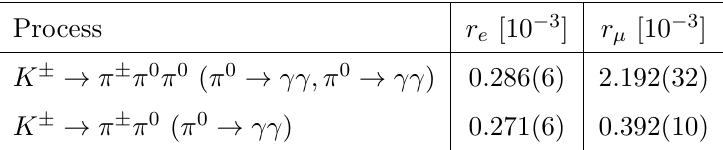
Table 2 . Background processes and background to signal ratios r e and r (cid:22) in the selected K (cid:6) K (cid:6) samples, estimated from MC simulations described in section 3. The quoted errors include (cid:22) 3 contributions from the external branching ratios and simulated